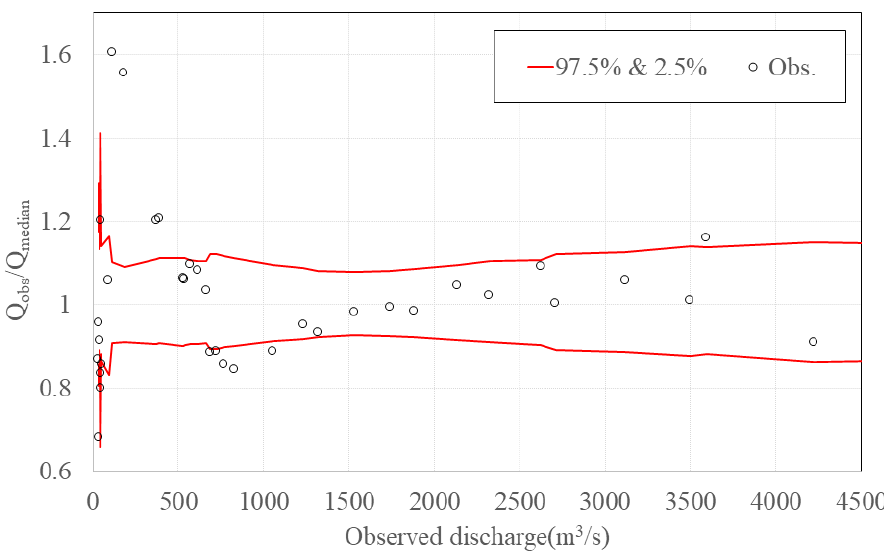
Figure 6. Ratio of median and observed discharge measured using ADCP.